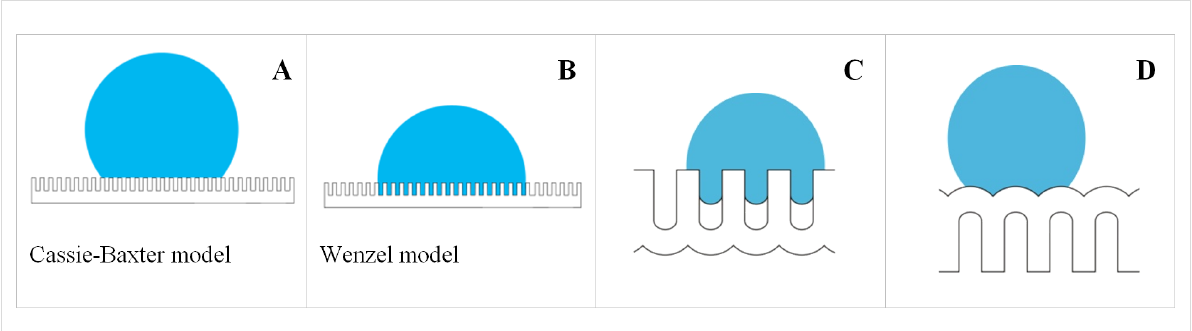
Figure 8: Schematic representation of the different models for pore wetting: A – Cassie–Baxter model [38], B – Wenzel model [38], C, D – schemes to explain wetting in our study.